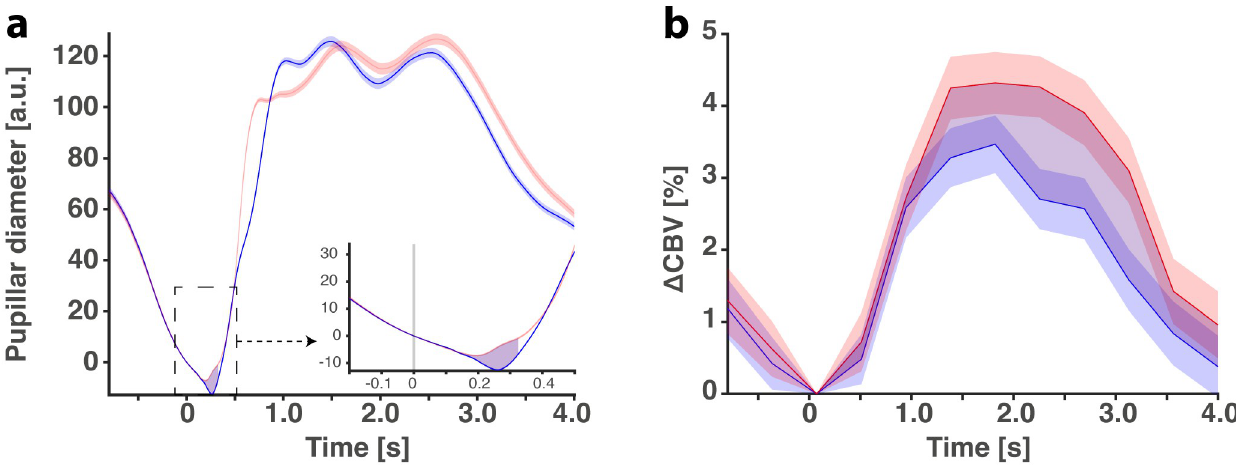
Fig 3. AU : ThefigurepartsaandbaremissinginFig 3 file : Pleaseprovideanupdatedfigurefile : Effect of cognitive effort (prosaccades versus antisaccades) on pupil diameter and cerebral blood flow. (a) Pupillary diameter for prosaccade (in blue) and antisaccade (in red) +/ − SEM averaged over all kept sessions in 2 animals. Purple area corresponds to the difference in the area under the curve one of both curves. (b) Same as (a) but for the Δ CBV. The data underlying the graphs shown in the figure can be found in https://osf.io/2q357/.